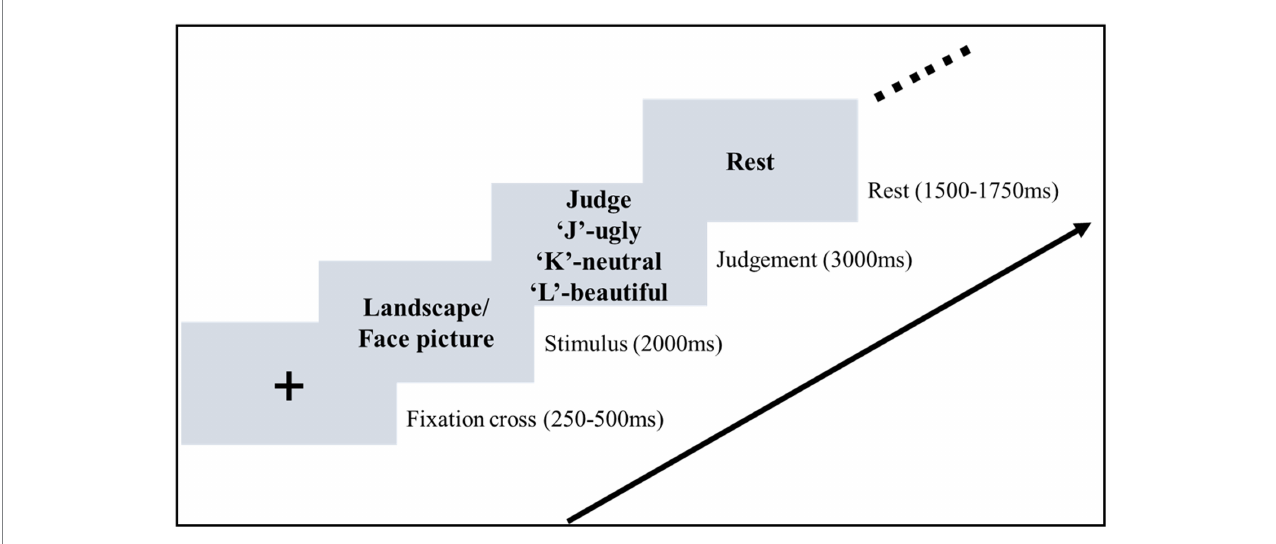
FIGURE 1 Stimuli sequence of the aesthetic judgment task. In the stimulus stage, participants were asked to pay attention to the picture and then evaluate the aesthetic valence in the judgement